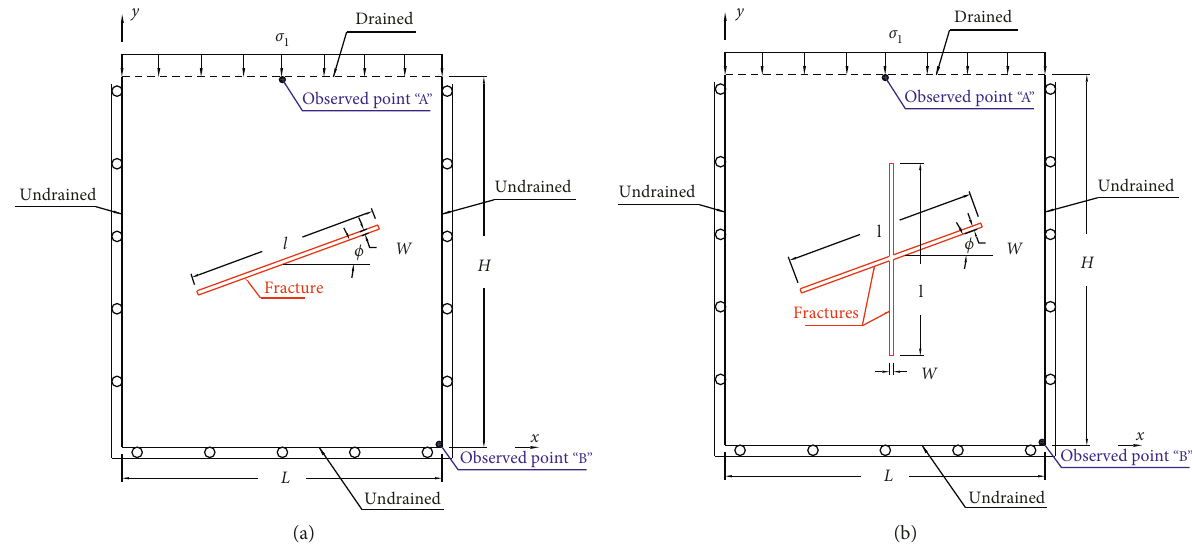
Figure 10: Sketch of the coupled hydromechanical tests with two configurations of fracture in the saturated porous medium: (a) one fracture; (b) two